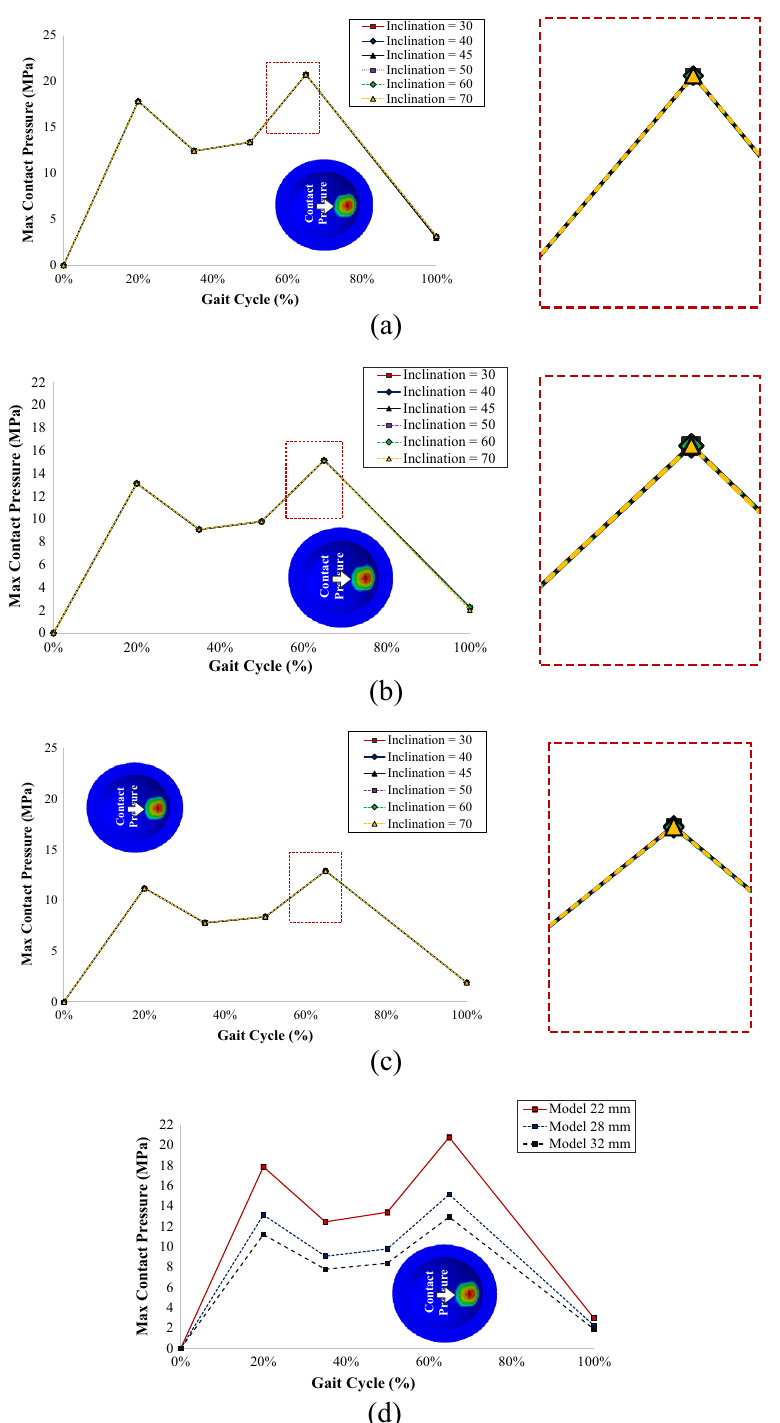
Figure 6. Contact pressure on the inner surface of the inner liner: ( a ) model with a 22 mm femoral head, ( b ) model with a 28 mm femoral head, ( c ) model with a 32 mm femoral head, ( d ) contact pressure comparison of different head diameters at 45° inclination